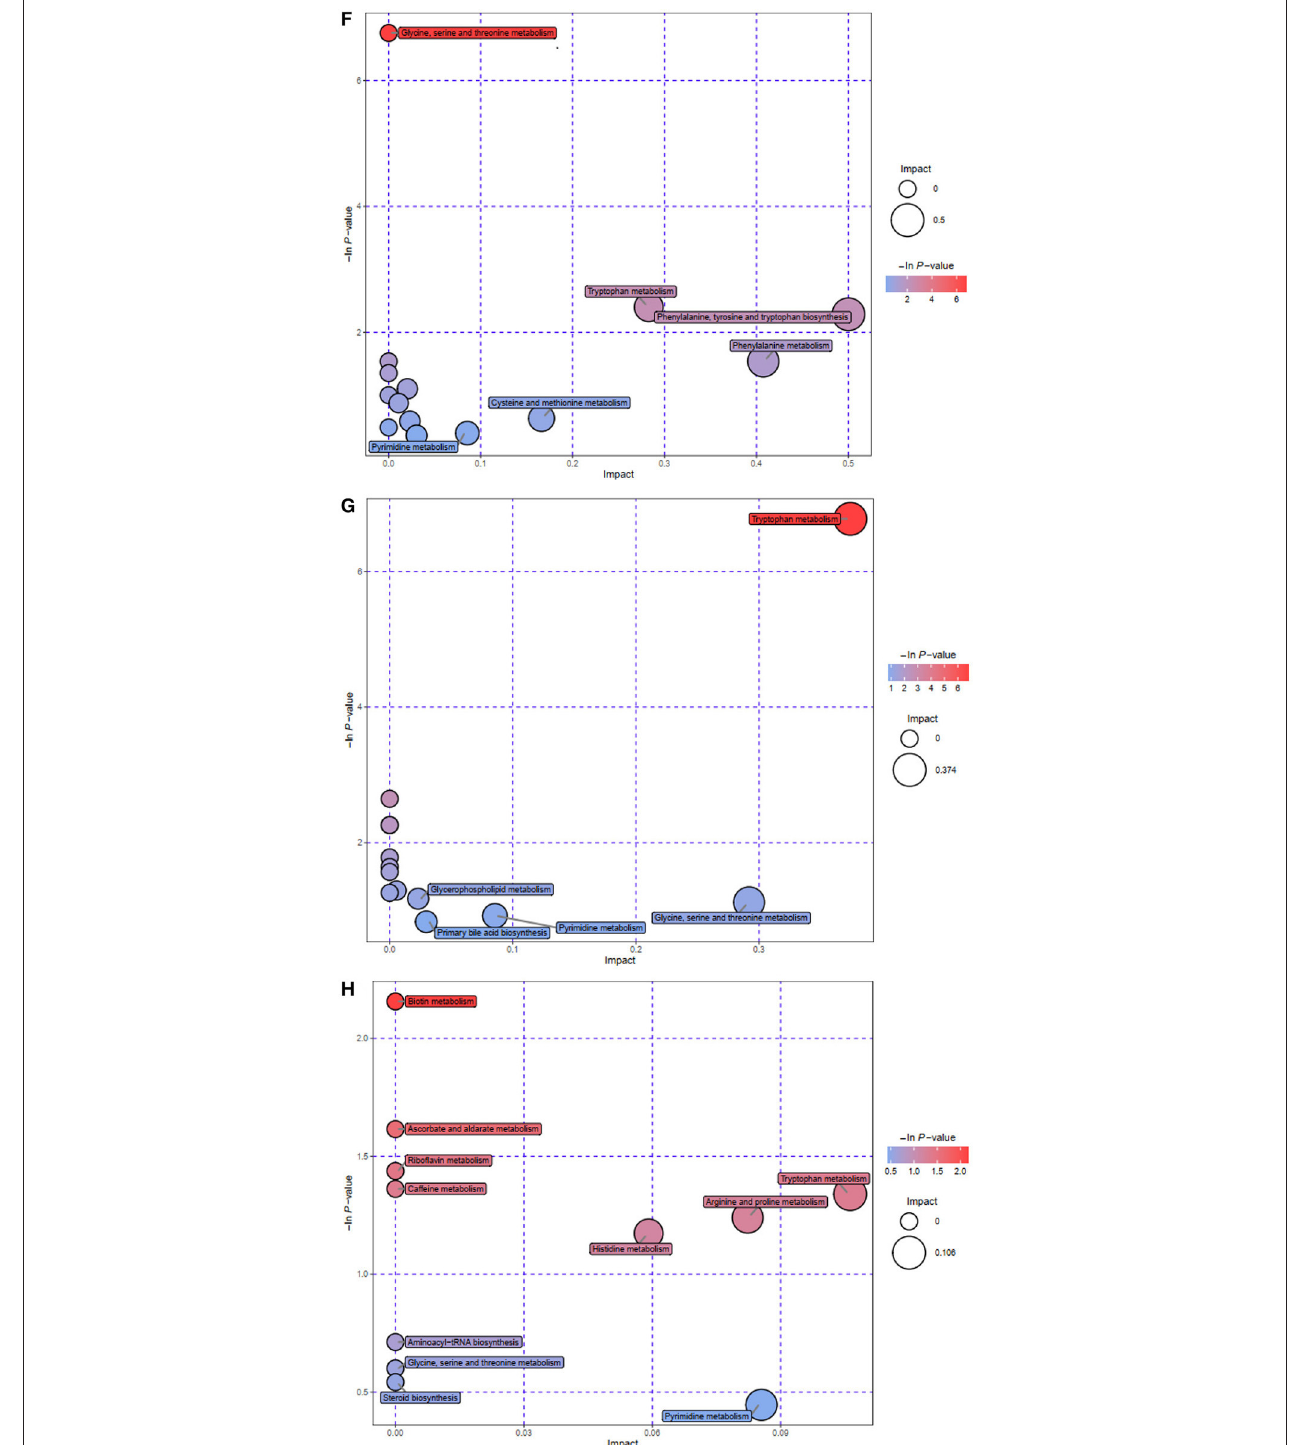
FIGURE 3 | Effect of diet intervention on the metabolites in serum. (A) The differentially expressed metabolites between LPG and CTG. (B) The differentially expressed metabolites between SPG and CTG. (C) The differentially expressed metabolites between CG and CTG. (D) The relative content of L-tryptophan. (E) The relative content of 5-hydroxy-L-tryptophan. (F) Bobble plot of LPG to CTG. (G) The bobble plot of SPG to CTG. (H) The bobble plot of CG to CTG. Data are presented as mean ± SEM. Different letters indicate statistical differences among the groups ( p < 0.05). CTG, control group; LPG, low protein group; CG, casein group; SPG, soy protein